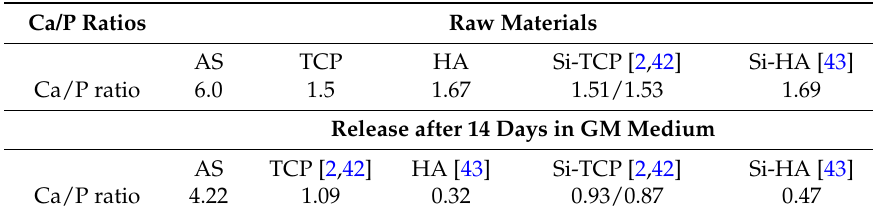
Table 1. Ca/P ratio in the AS material as well as some calcium phosphate (CaP) and Si doped CaP